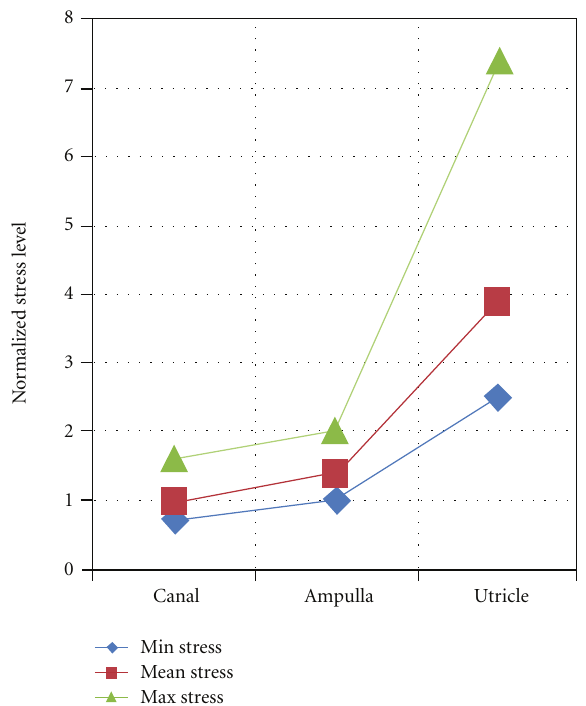
Figure 5: Normalized stress levels in the toadfish vestibular membranes. Mean, maximum, and minimum individual values for each of the three vestibular chambers are shown